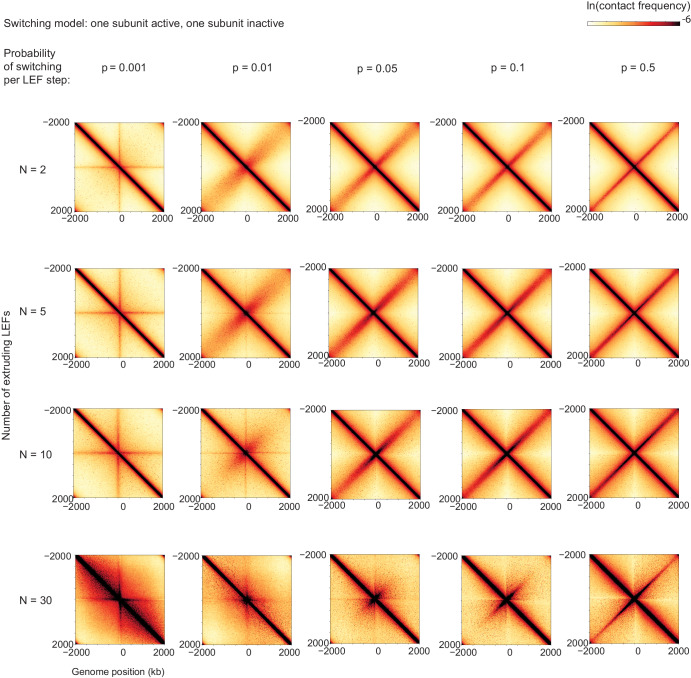
Contact maps from simulations for scaled switching rates and numbers of LEFs for bacterial chromosomes.Switching probability per active translocation step increases from left to right and number of LEFs increases from top to bottom. Note that switching probabilities are given in simulation step units; from left to right, these correspond to units of kswitchL/v of 4, 40, 200, 400, 2000; in units of switching rate, kswitch, from left to right these correspond to 0.001 s−1, 0.01 s−1, 0.05 s−1, 0.1 s−1 and 0.5 s−1 for B. subtilis.